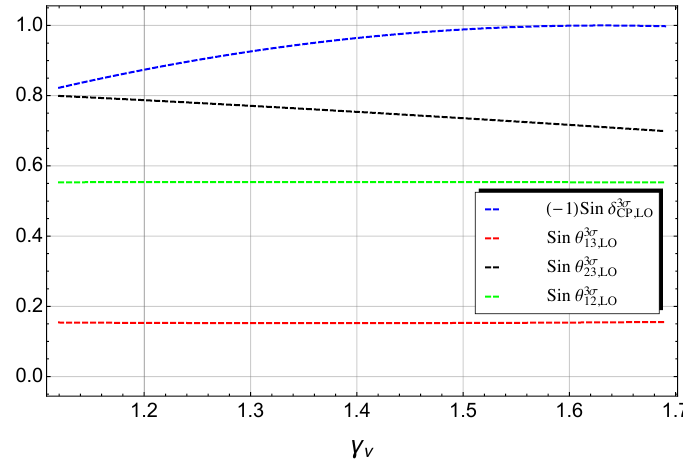
Figure 2 . Predictions obtained for V PMNS observables upon constraining the phase dependence of these observables with the 3 (cid:27) data from NuFit and assumptions described in section 5.2. In this example we only utilize the L.O. UTZ